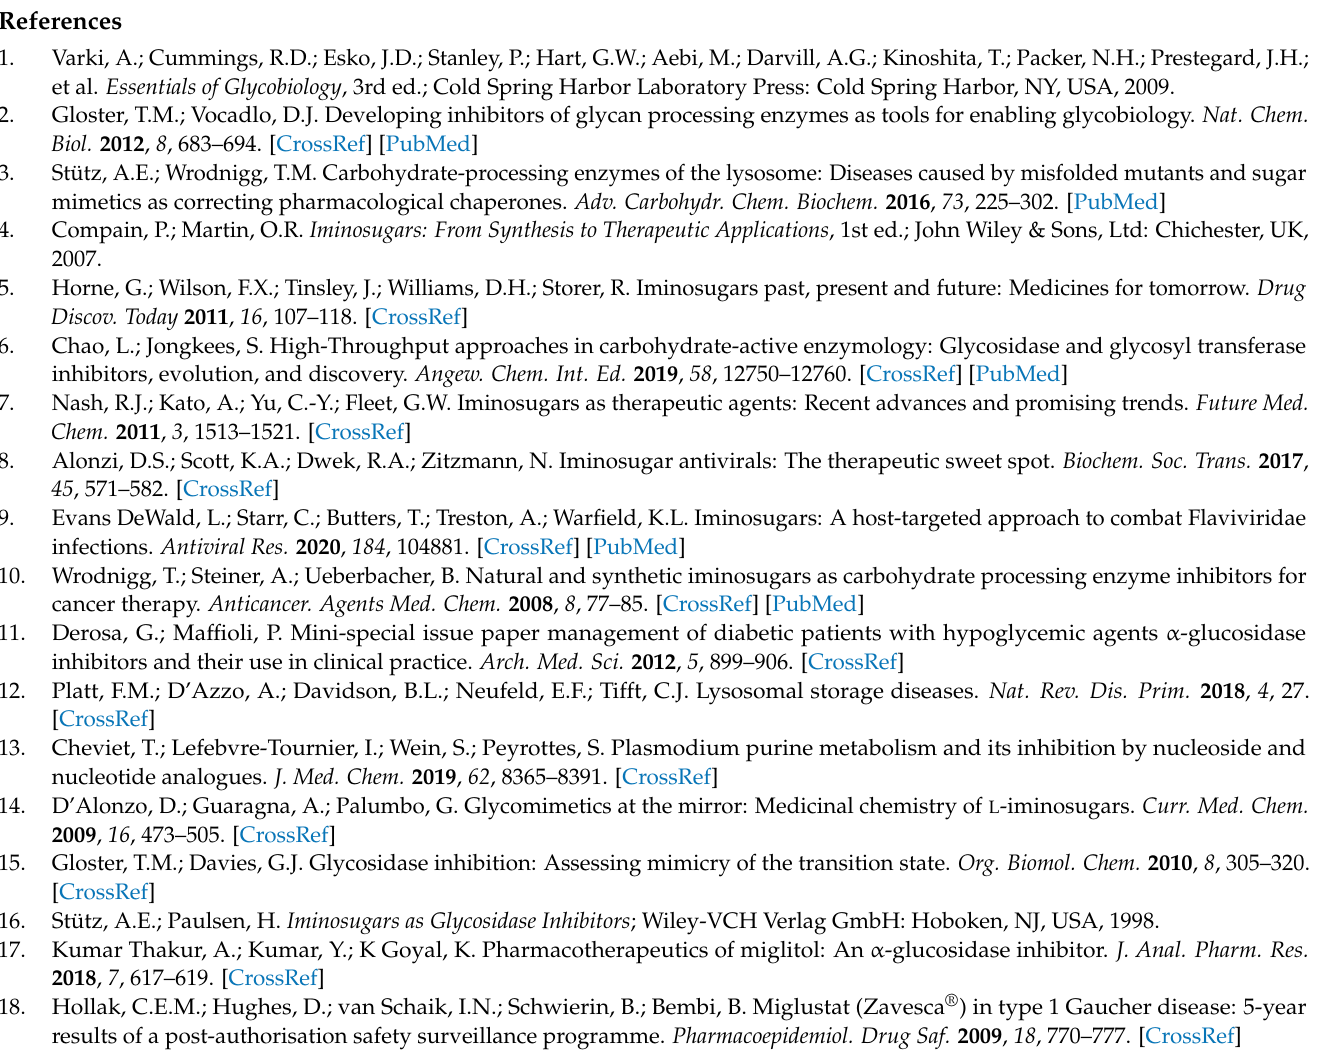
Supplementary Materials: Figure S1: 1H and 13C NMR spectra of compound 8; Figure S2: 1H and 13C NMR spectra of compound 10; Figure S3: 1H and 13C spectra of compound 11; Figure S4: 1H and 13C NMR spectra of compound 12; Figure S5: 1H and 13C NMR spectra of compound 13; Figure S6: 1H and 13C NMR spectra of compound 3; Figure S7: 1H and 13 C NMR spectra of compound